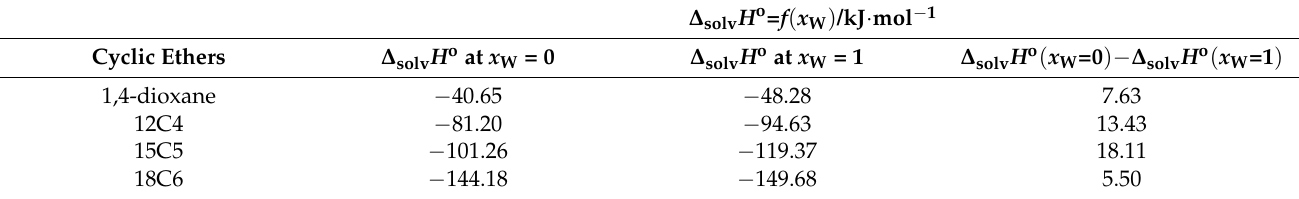
Table 1. Changes in ∆ solv H o = f ( x W ) for cyclic ethers in the F + W mixture at 298.15